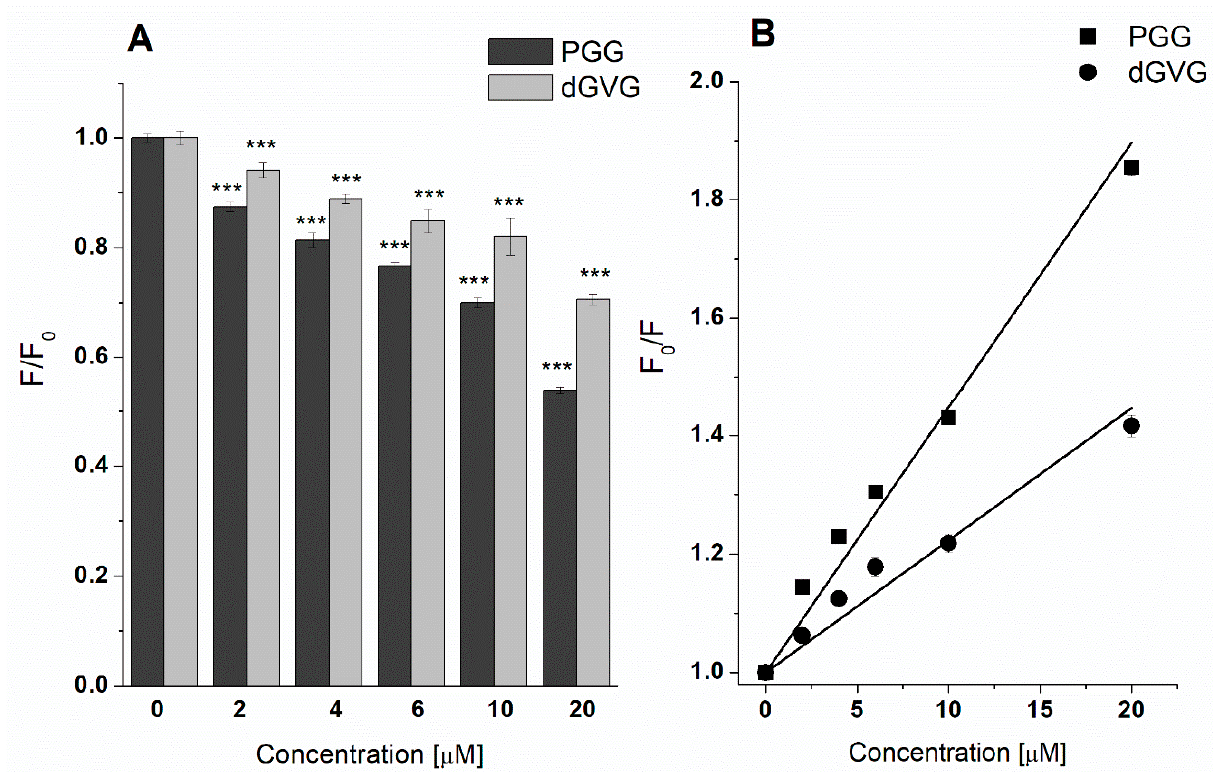
Figure 5. Fluorescence decrease ( A ) and Stern–Volmer plots ( B ) of S. aureus membrane stained with DPH. Values presented as relative fluorescence. The data presented are the means ± SD, n = 6. Statistical significance was estimated using a one-way ANOVA test (results compared to control, *** p < 0.001).